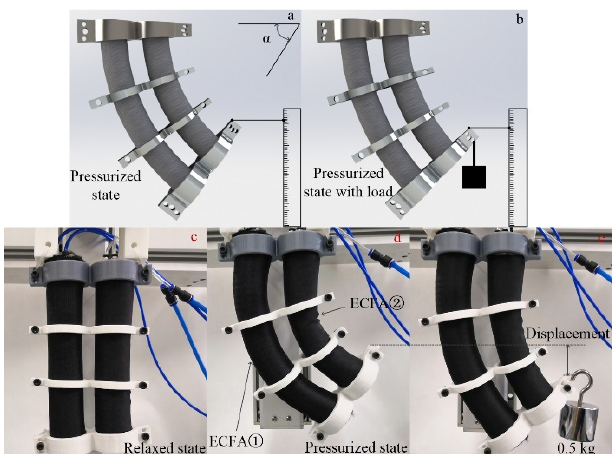
Figure 12. ( a , b ) are the method to test the stiffness of the soft manipulator, that is, applying weights to produce displacement under pressurized bending state. ( b–e ) are a period of experiment process when the manipulator under relaxed and pressurized state and ( c ) is bending attitude when the extensor of ECFA 1 (cid:79) is 0.2MPa and the contractor of ECFA 2 (cid:79) is 0.1 MPa. Table 4. Results of varying sti ff ness without bending angle changing of the manipulator. Experiment